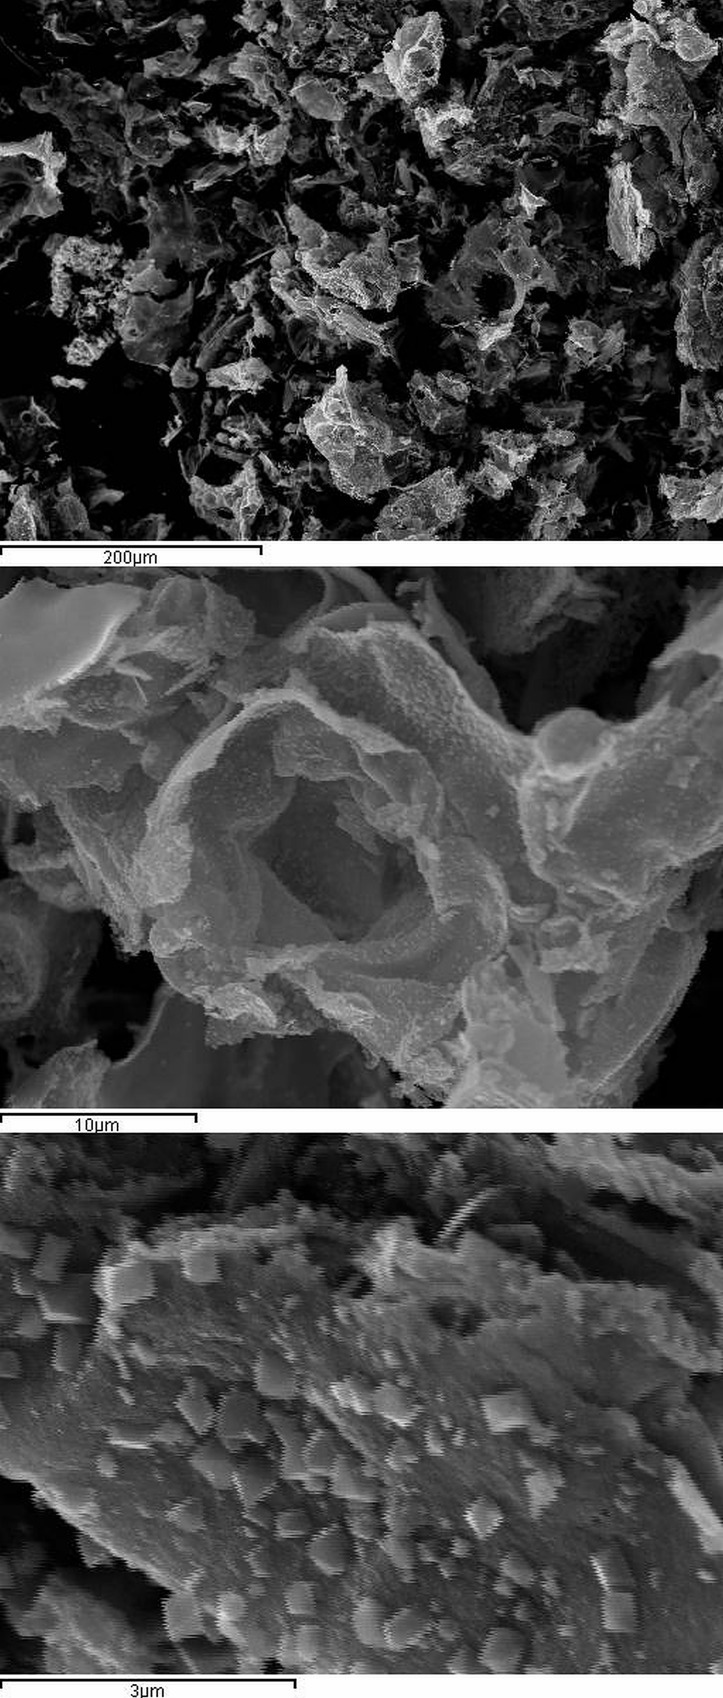
The SEM microphotographs of MnCo2O4 samples obtained with the temperature Tf = 500°C.